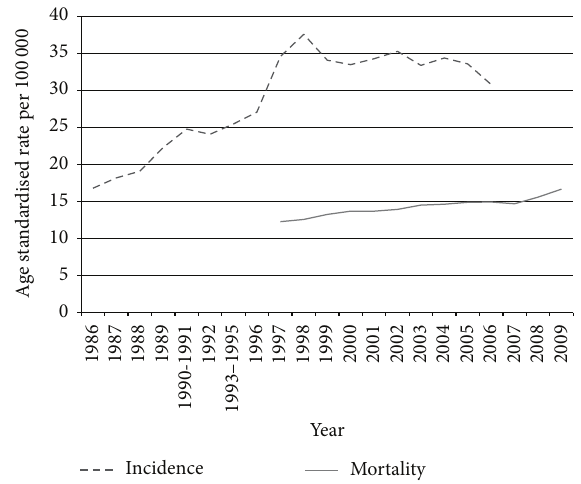
Figure 4: Prostate cancer in South Africa, age standardised inci- dence rate (1986–2006) from the pathology based National Cancer Registry and age standardised mortality (1997–2009) rate from Statistics SA mortality data, per 100